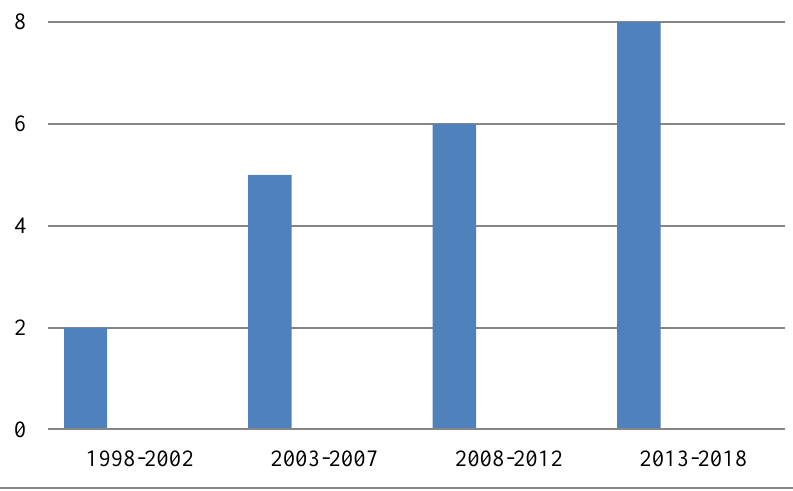
Figure 13. Period of 21 papers that showed the degree of agreement about accident types. “Source: